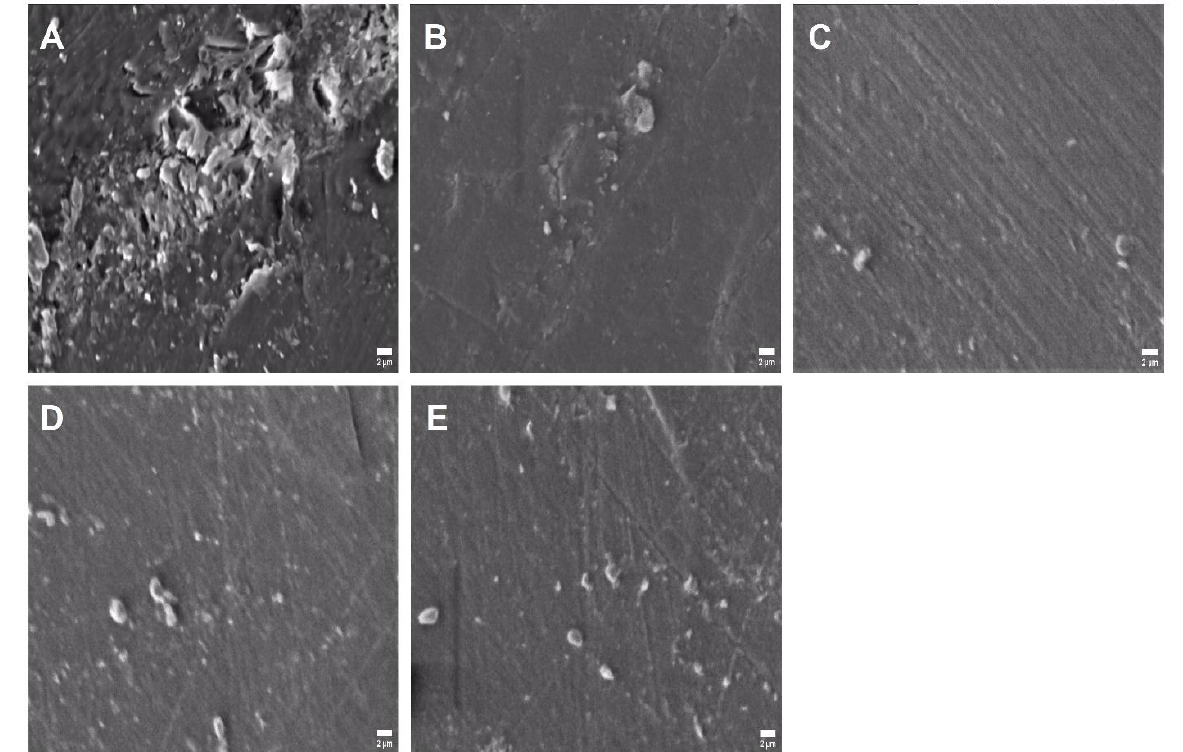
Figure 7. Scanning electron microscope (SEM) images showing the effects of caffeine (CAF) against the growth of C. albicans adherent to the PMMA discs at X5000. ( A ) Adherent fungal cells in control group (PBS) containing no treatments. ( B ) Limited number of the adherent fungal cells in chlorhexidine (CHX) group. ( C – E ) Different descending concentrations of CAF including 60, 30, and 15 mg/mL, respectively, showing the dose-dependent effects of CAF and the gradual reduction of the adherent fungal cells on the PMMA discs.